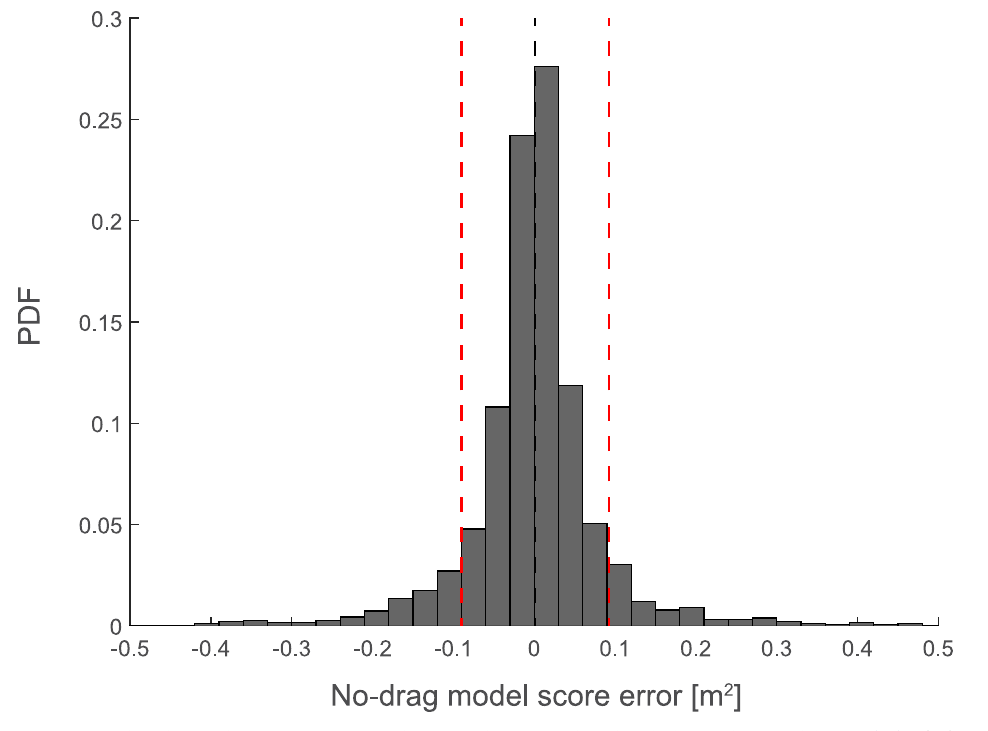
Fig 9. Error distribution between experimental score and score predicted with the no-drag model in Eq (29). Black and red vertical dashed lines indicate mean and ± 1 SD of the distribution, respectively.